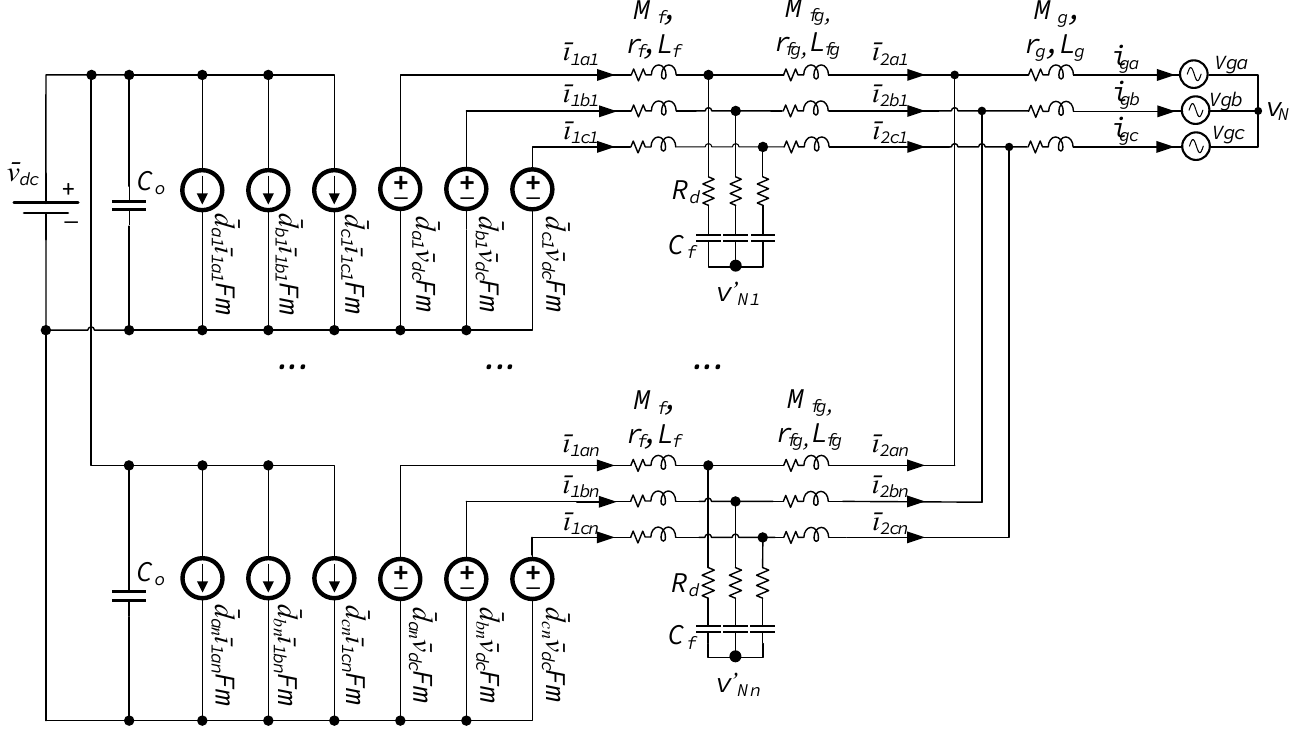
Figure 2. Averaged equivalent circuit of the parallel inverters.